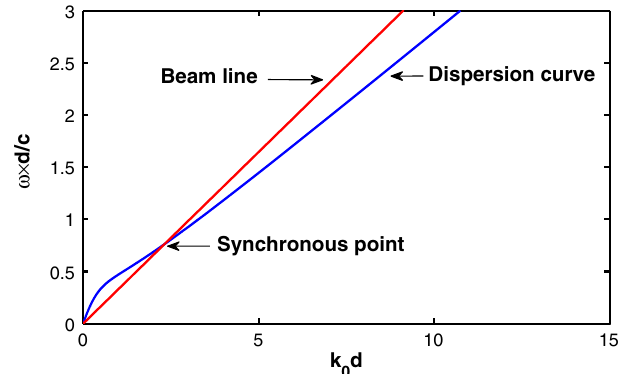
FIG. 2. Plot of the dispersion curve of the surface mode, and the Doppler line for the electron beam. At the intersection, we find the resonant frequency of the system. Parameters used in the calculation are given in Table